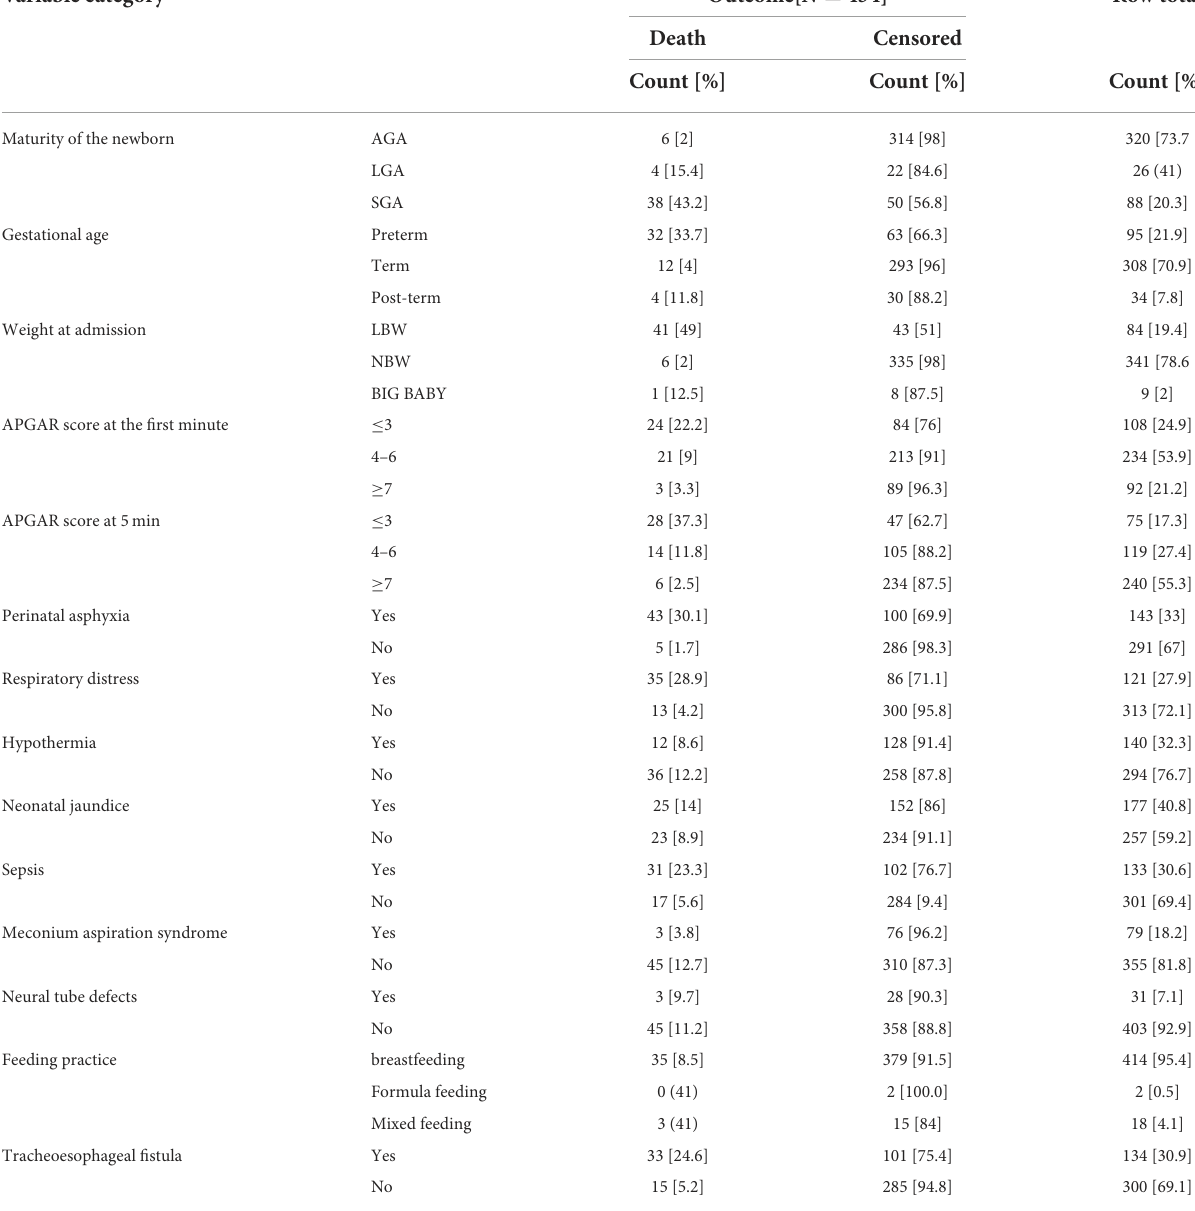
TABLE 5 Neonatal medical conditions or assessments who were admitted at NICU of TASH, Addis Ababa, Ethiopia, from 1 January 2015 – 30 December